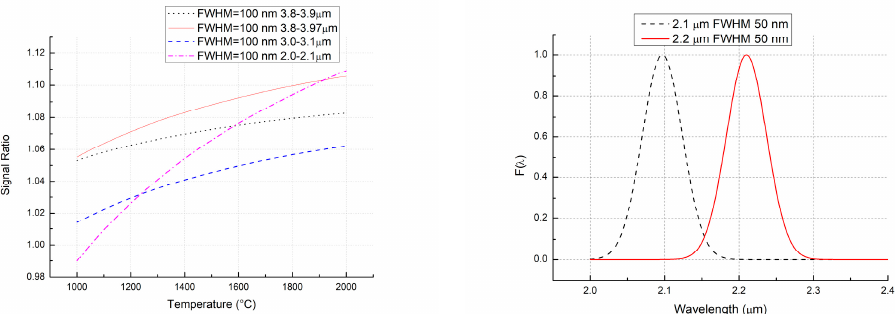
Figure 7. ( Left )—the SR trend versus T for different pairs of filters analysed. ( Right )—the Gaussians of the response curves of the best filter combination.